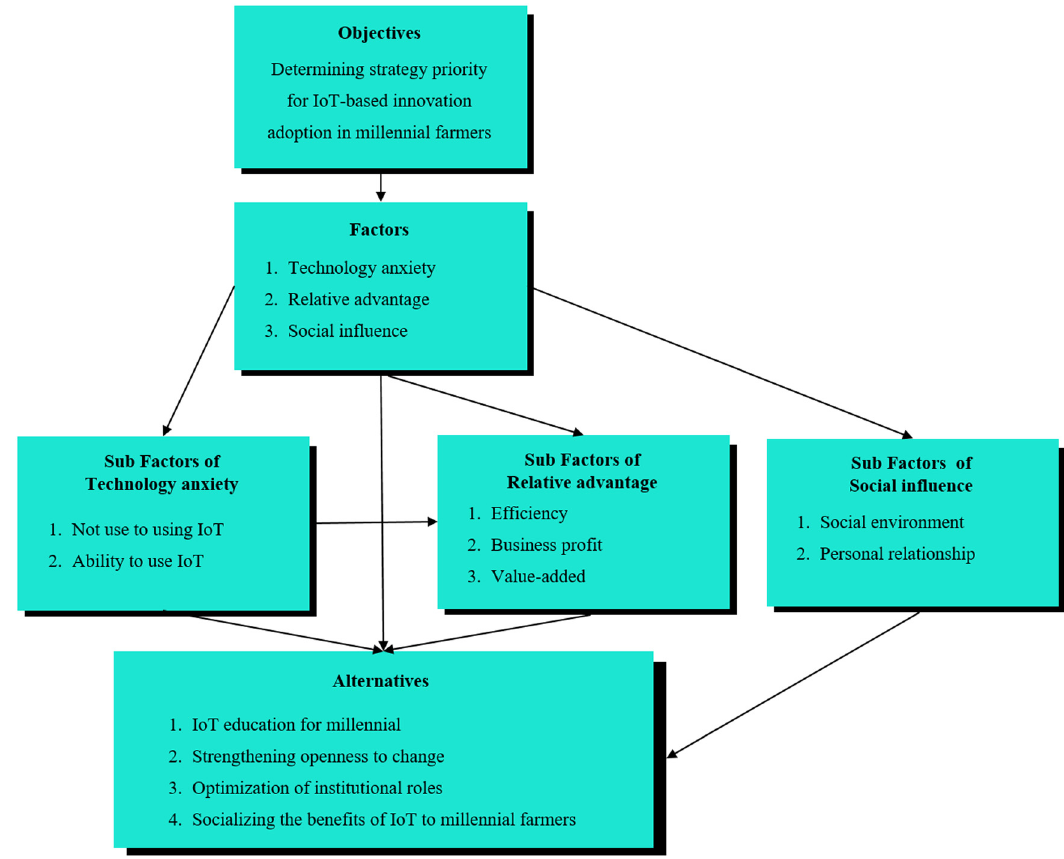
Figure 2: Network structure in strategy priority for IoT - based innovation